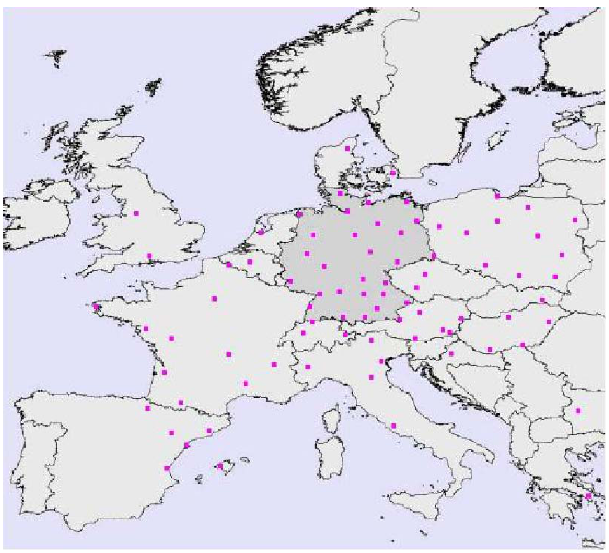
Fig. 2. Location of more than 100 sensor sites of the Nowcast light- ning detection network LINET, as of April 2008 (provided by Now- cast GmbH).